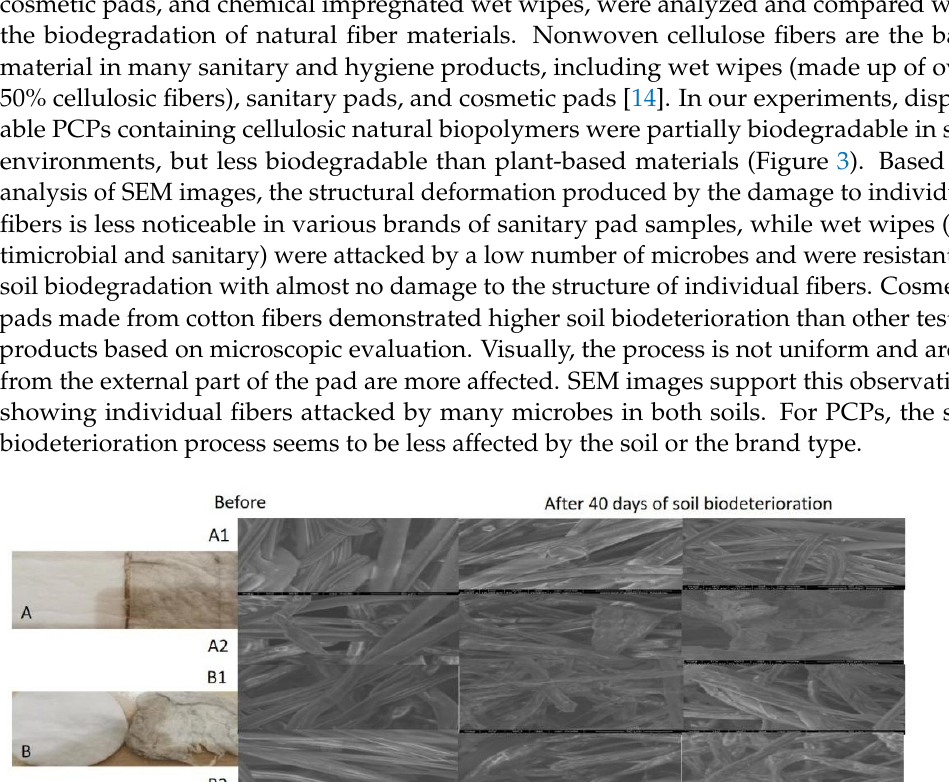
Figure 2. Biodeterioration of animal-based products (A—wool and B—leather, F—front side and B—back side) in soil #1 from Ceatalchioi and soil #2 from Bididia-Mineri. Material morphology changes were observed using stereomicroscope (right images) and scanning electron microscopy (2000×/4000×) (left images).